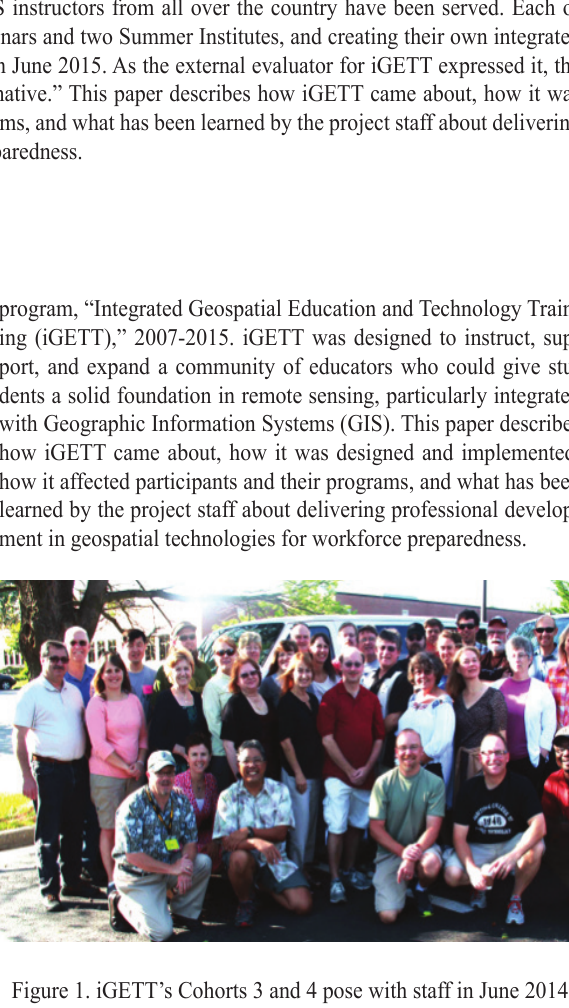
Figure 1. iGETT’s Cohorts 3 and 4 pose with staff in June 2014 at Northern Virginia Community College where